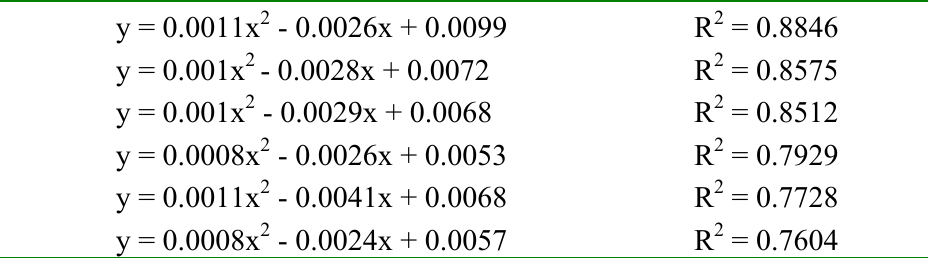
Table 1. Relationship between LAI and different hyperspectral